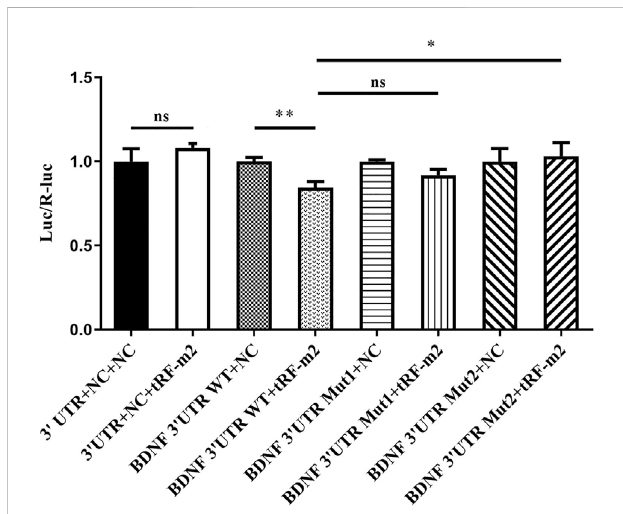
Therepressiveeffect oftRF-1-32-Gly-GCC-2-M2 on theactivityof the site of BDNF 3 ′ UTR measured by dual luciferase reporter assays, indicating that tRF-1-32-Gly-GCC-2-M2 directly targeted BDNF. Data presents as means ± SEM, * p < 0.05, pp p <